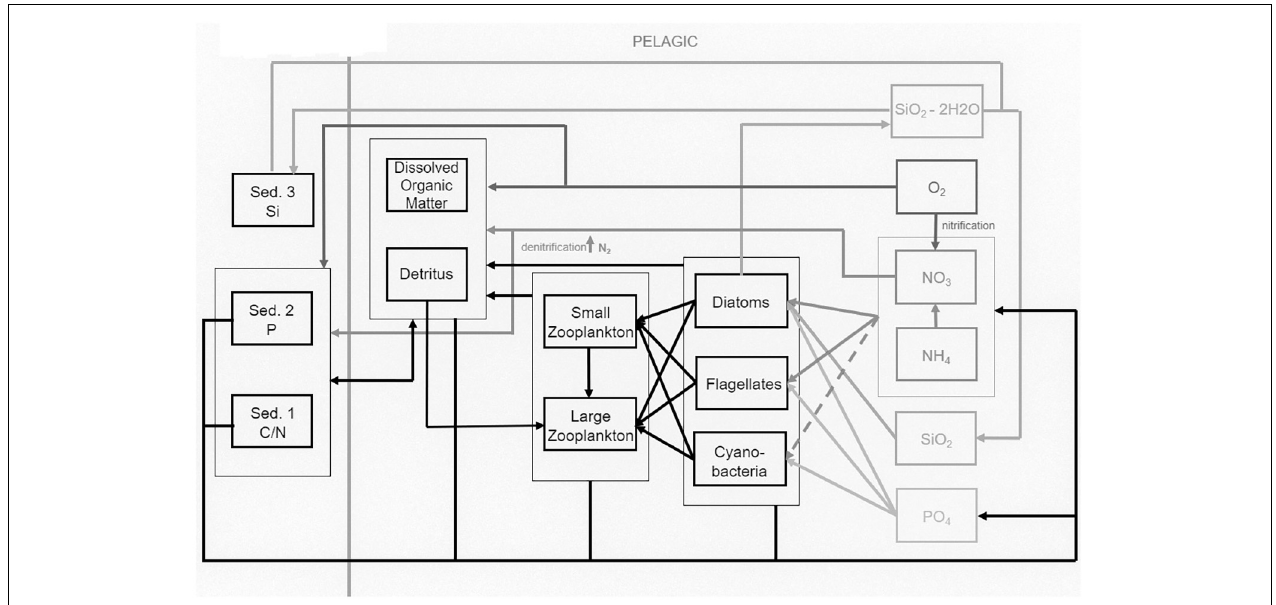
FIGURE 2 | Links between the pelagic and benthic state variables in ECOSMO2 [figure adapted from Benkort et al. (2020)].